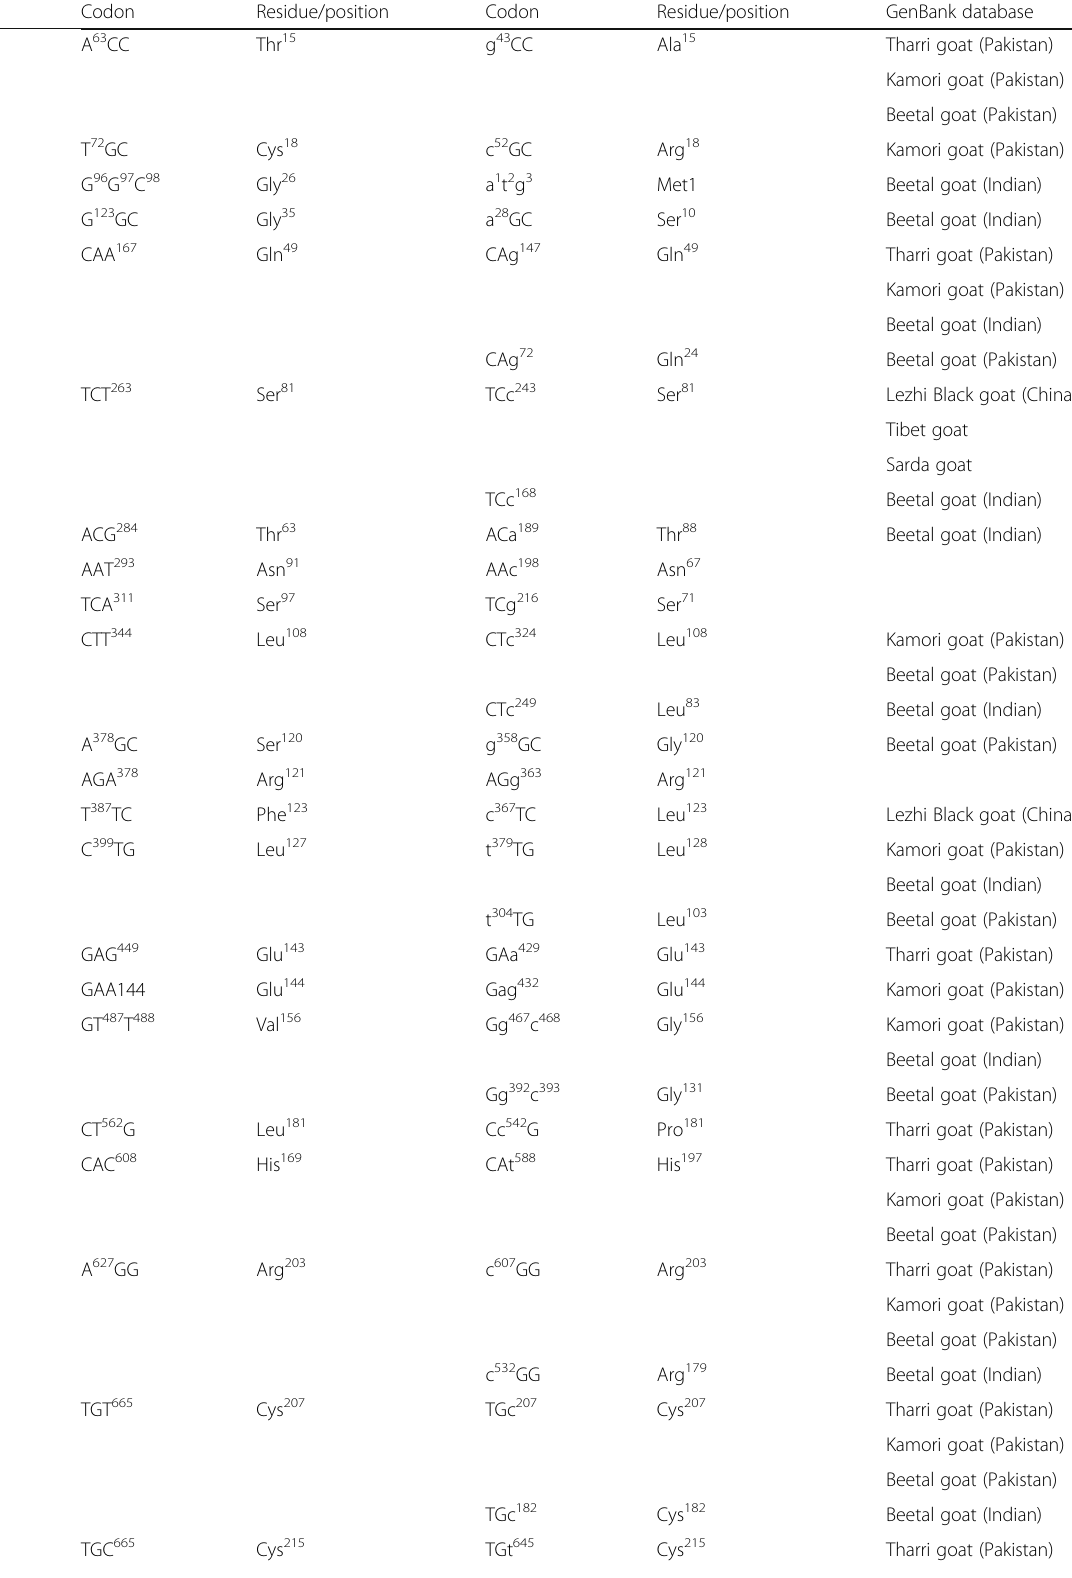
Table 2 Multiple alignment of Bo_GH cDNA sequence with GenBank goat database Current